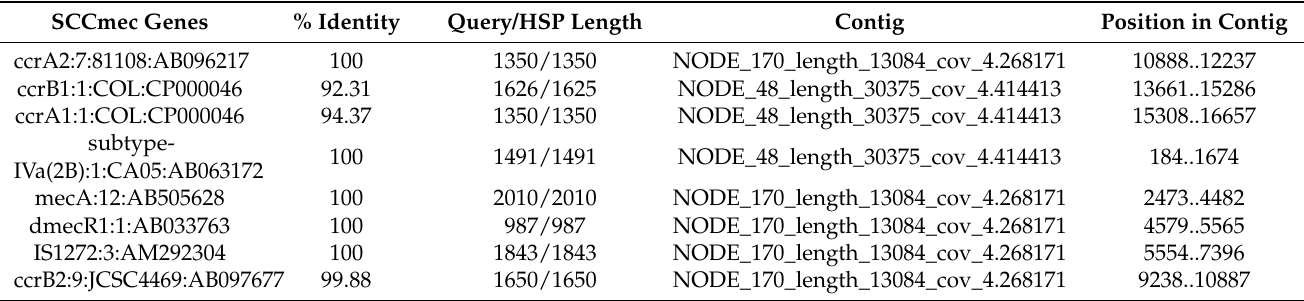
Table 3. SCCmec cassettes genes identified in the metagenome-assembled Staphylococcus aureus genome. SCCmec, Staphylo- coccal Cassette Chromosome mec ; HSP, high scoring pair. SCCmec